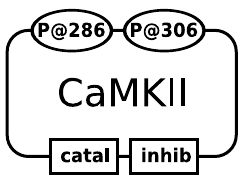
Figure 2.16: An example representation of calcium/calmodulin kinase